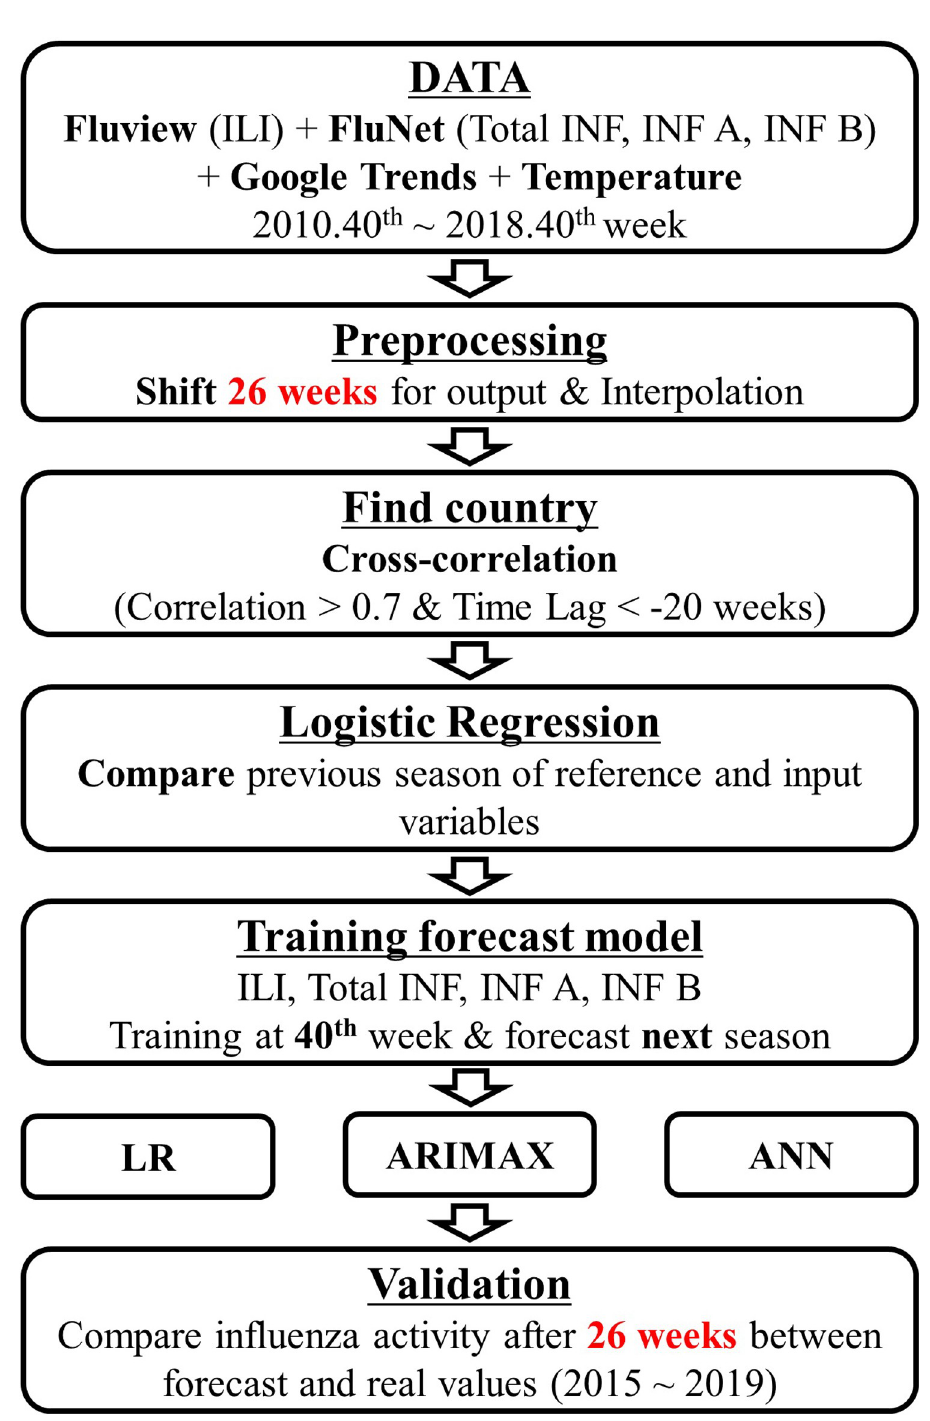
Fig 1. The flow chart for this